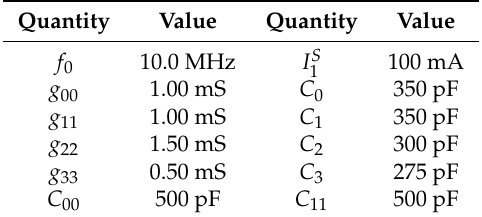
Table 1. Given network simulation parameters for the analyzed numerical example.